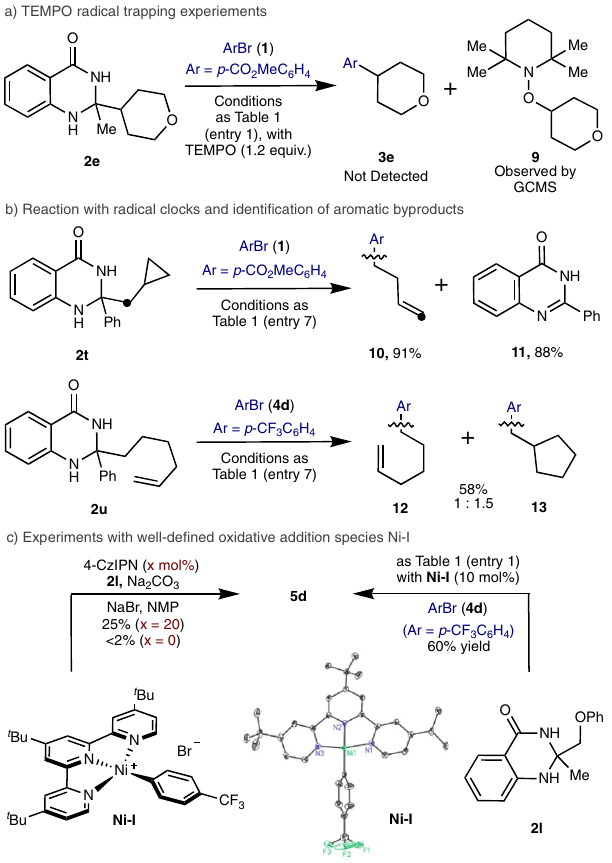
Fig. 5 Preliminary mechanistic experiments. a TEMPO radical trapping studies. b Radical clock experiments. c Mechanistic experiments with well- de fi ned nickel species.